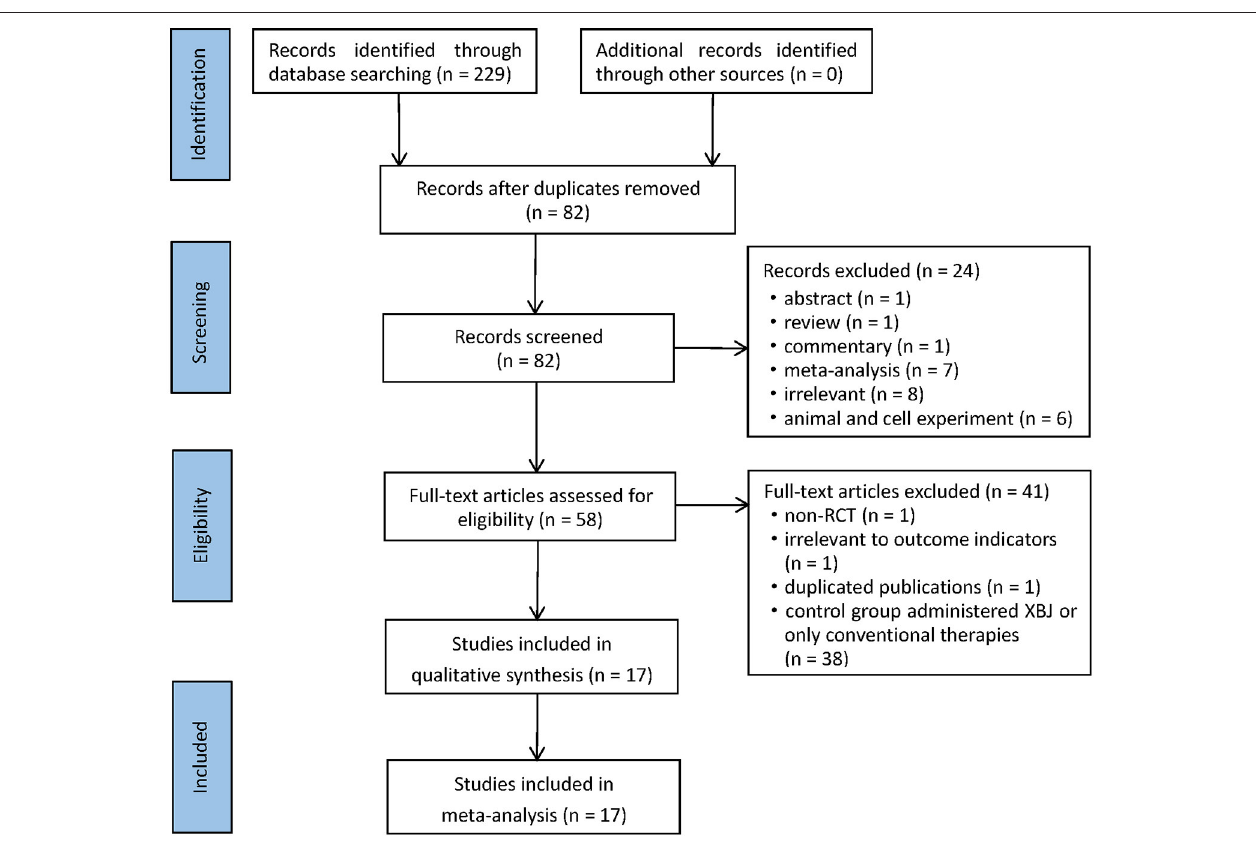
FIGURE 1 | Flow chart of literature